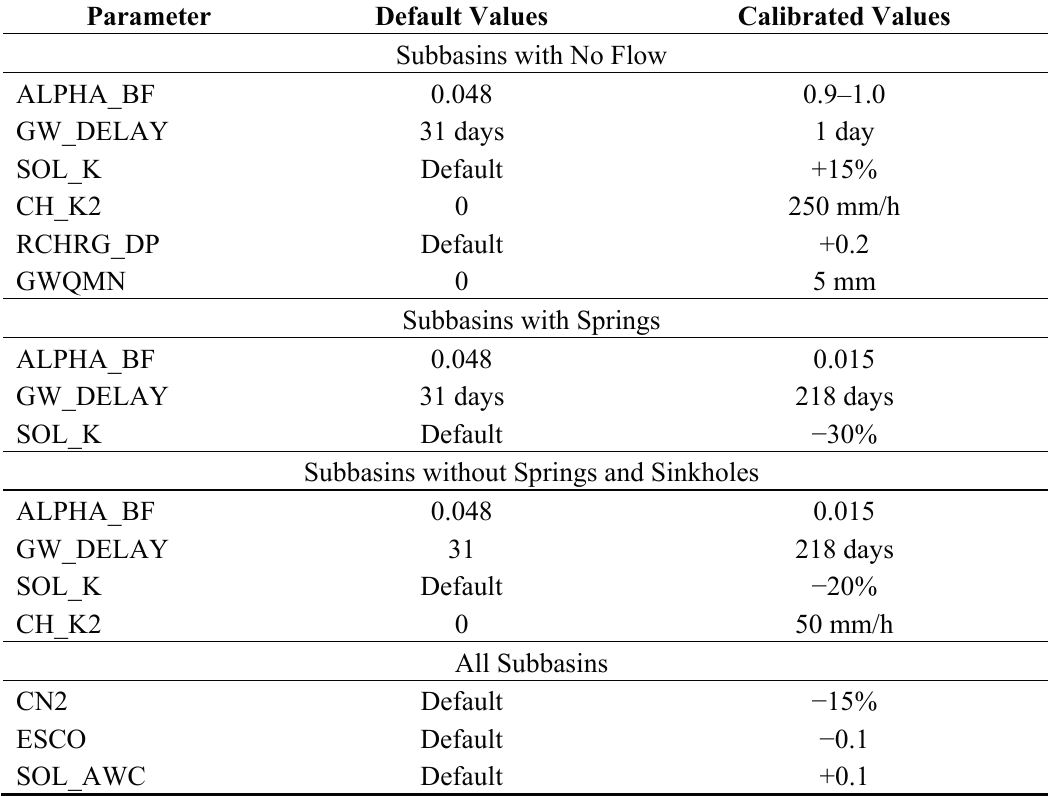
Table 2. Parameters adjusted during the calibration of the soil and water assessment tool (SWAT)